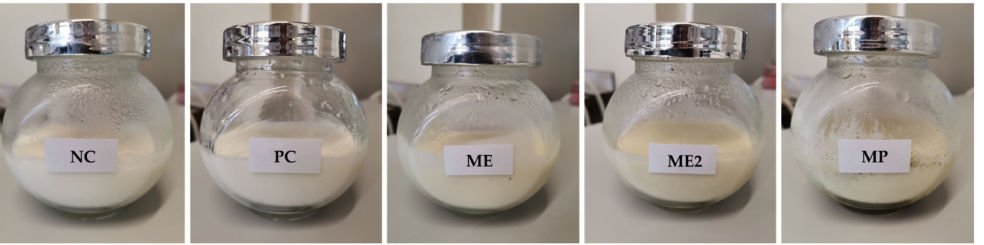
Figure 3. Yoghurt formulations appearance after production. NC—yoghurt with no additives (negative control); PC—yoghurt with sorbic acid (positive control); ME—yoghurt with 1 g/L of M. oleifera extract; ME2—yoghurt with 2 g/L of M. oleifera extract; MP—yoghurt with 2.9 g/L